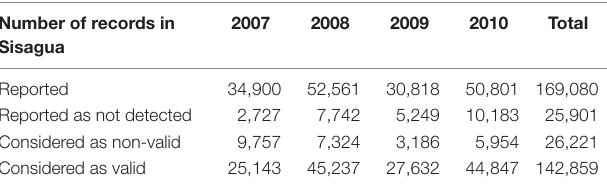
TaBle 5 | number of pesticides analysis results after sisagua data selection for the period (2007–2010). number of records in sisagua